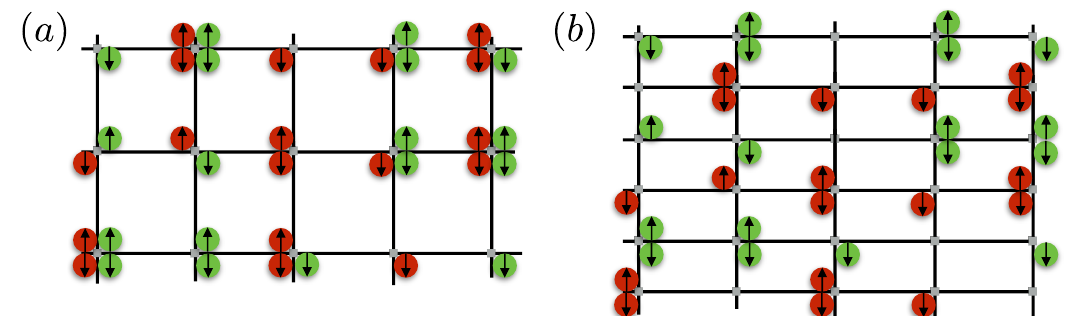
Figure 7: Schematic depiction of two-band setups for a spinful Hubbard model, with the two bands depicted by the different colors red and green. In setup (a) all four fermionic flavors still reside on a given lattice site, leading to an enlarged Hilbert space of d = 4 2 . This setup respects flavor symmetry, which thus may be exploited. Setup (b) avoids the enlarged local Hilbert space by splitting the lattice into two sublattice, one for each band. This comes at the cost of introducing an additional set of sites, causing interaction terms to become longer-ranged.